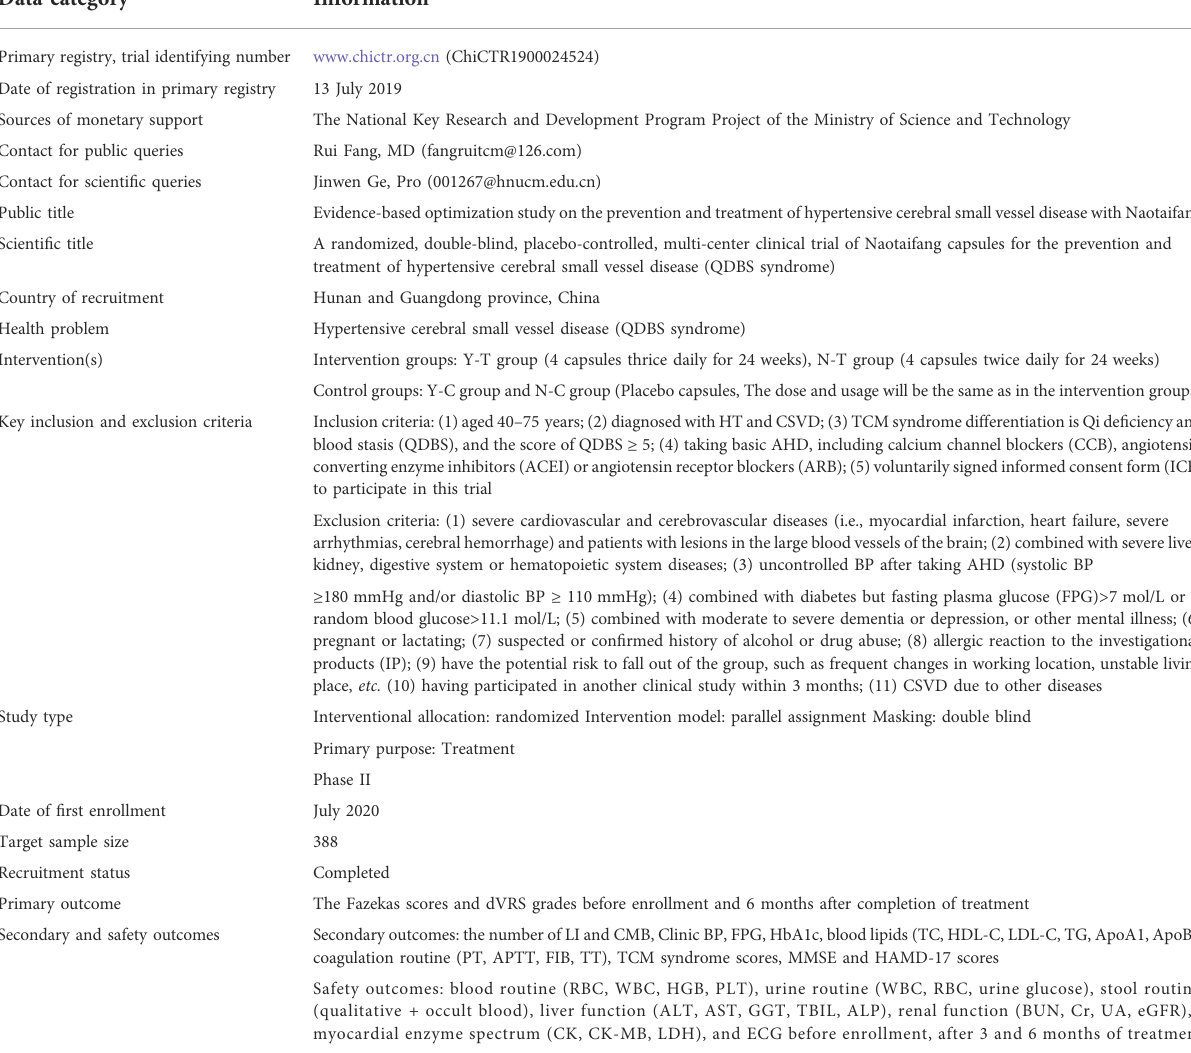
TABLE 1 WHO trial registration data set — structured